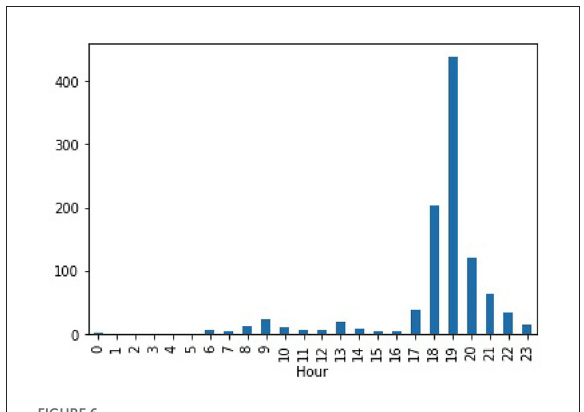
FIGURE6 Avg. power/hour for Dishwasher in House 2.